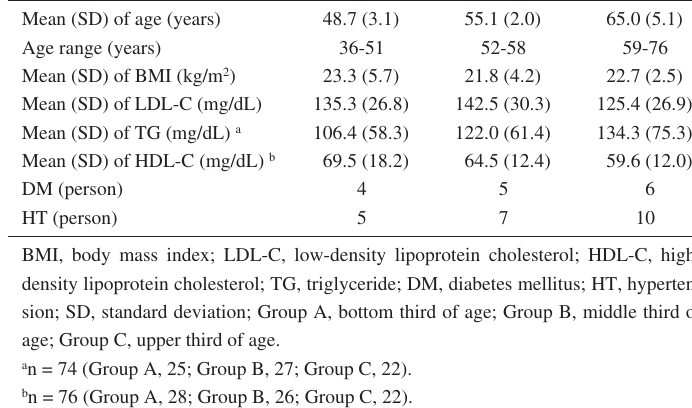
Table 1. Background characteristics of the three groups.